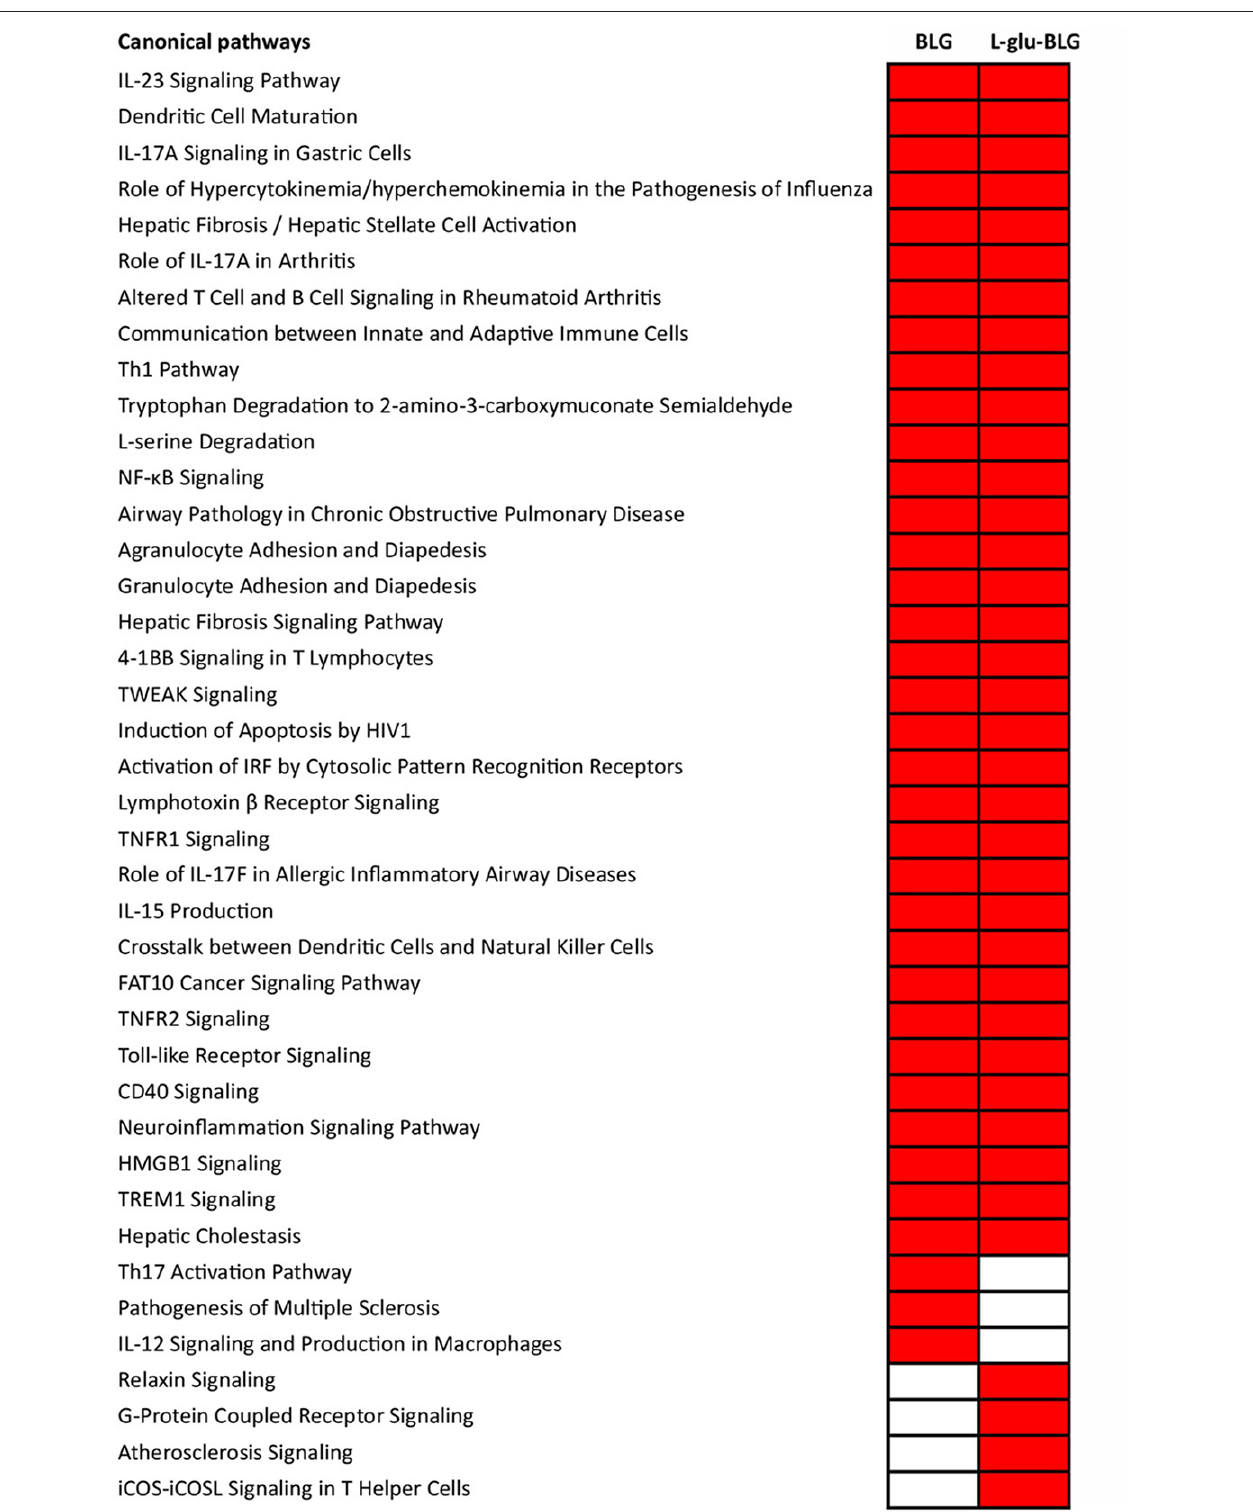
FIGURE 8 | Significantly associated canonical pathways in THP-1 derived macrophage-like cells (M0) incubated with BLG and L-glu-BLG were mostly related to immune responses. THP-1 monocytes were differentiated into M0 cells and were incubated with medium (non-treated), native or L-glu-BLG for 6h. Microarray analysis provided data on the transcriptome which was expressed as average fold change between treated vs. non-treated cells of 3 independent experimental